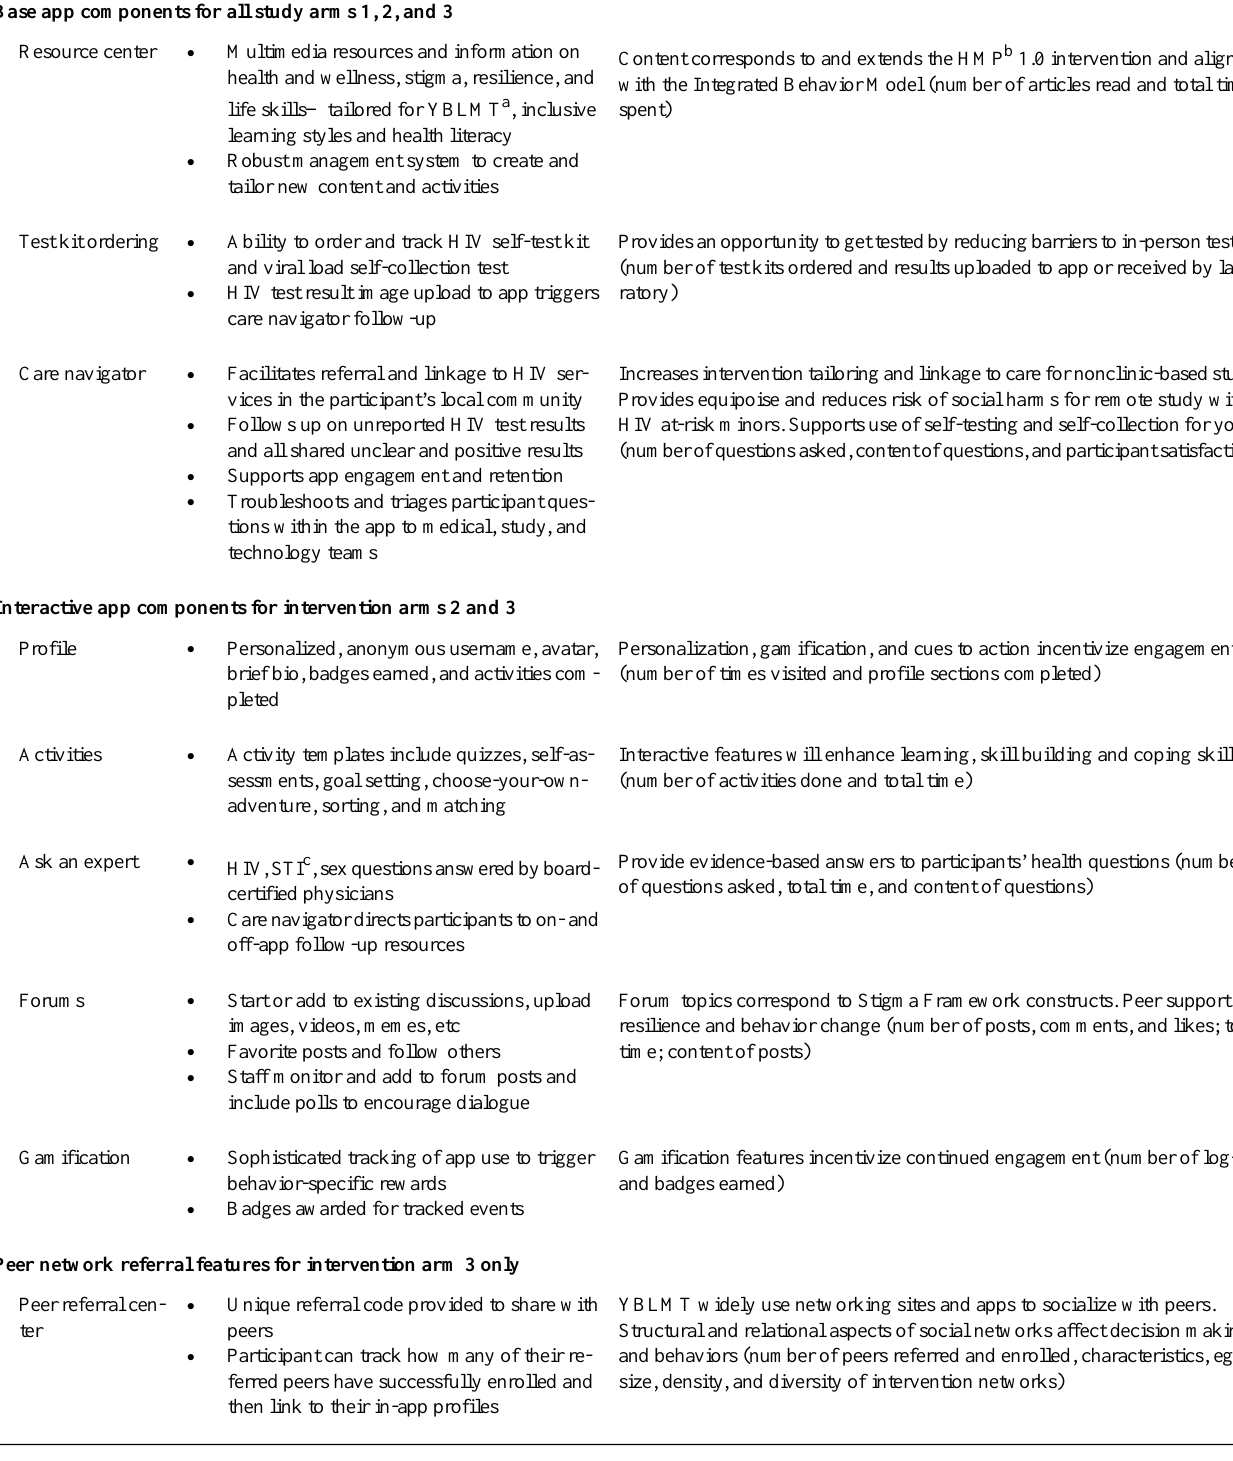
Table 1. HealthMpowerment 2.0 core components, scientific rationale, and measurement metrics. Base app components for all study arms 1, 2, and